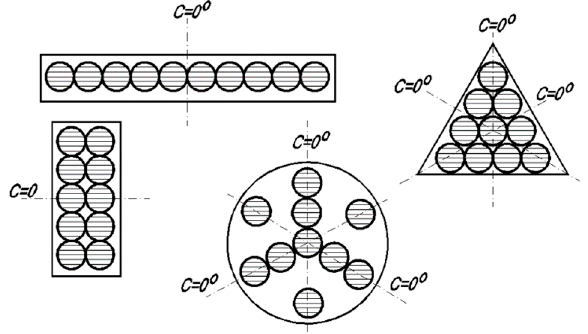
Figure 4. In many cases, an error is made when the coordinate system is set only on the basis of the outer dimensions of the luminaire. Therefore, the C0 plane defined based on the longitudinal and transverse directions and the optical axis is not the main plane for shaping the luminous intensity distribution.